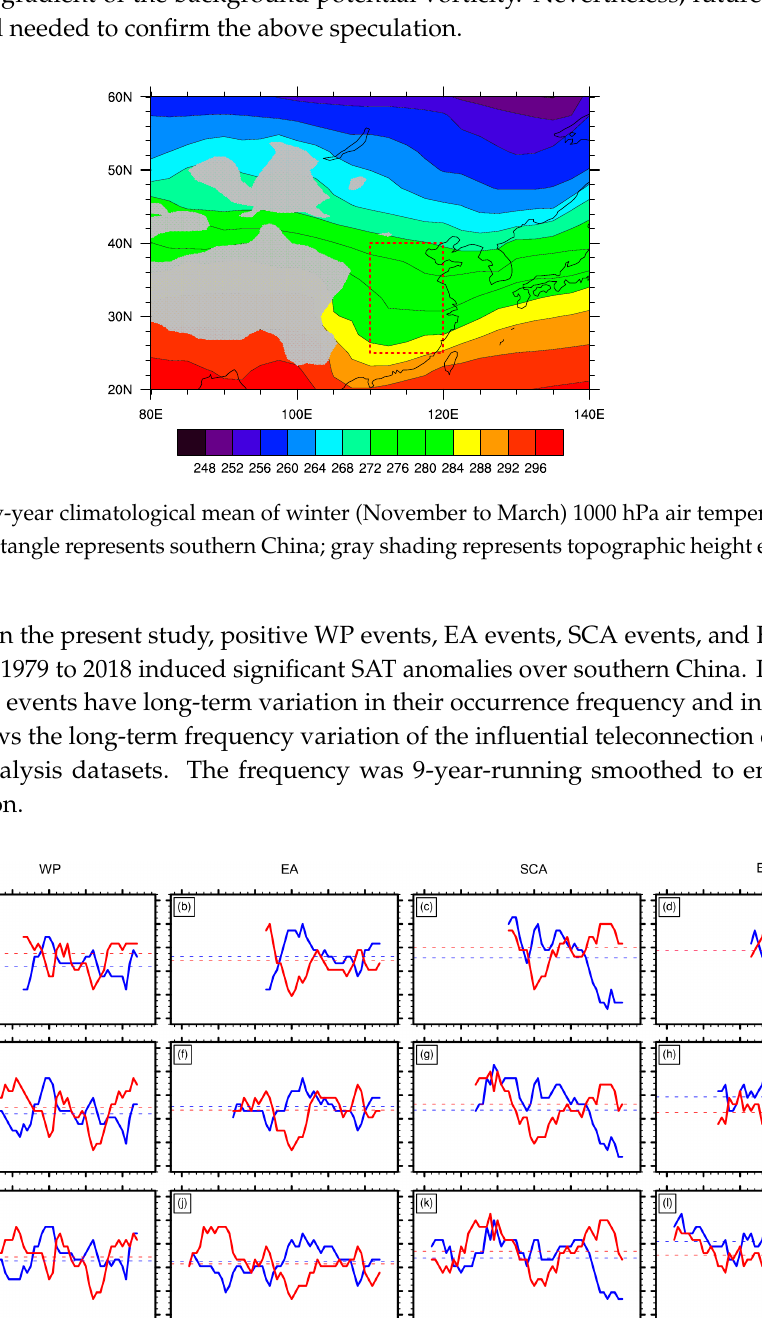
Figure 9. Nine-year running mean of the frequency of four teleconnection patterns, as revealed in ERA-interim (upper row), NCEP/NCAR (middle row), and JRA (lower row). Red (blue) lines represent the frequency of teleconnection patterns in their positive (negative) phase. The horizontal dashed red (blue) lines represent the mean frequency of the positive (negative) teleconnection patterns over the periods covered by the reanalysis datasets.